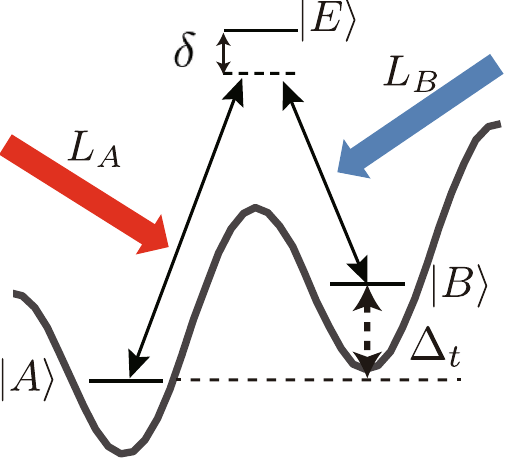
Figure 7. Λ -shaped